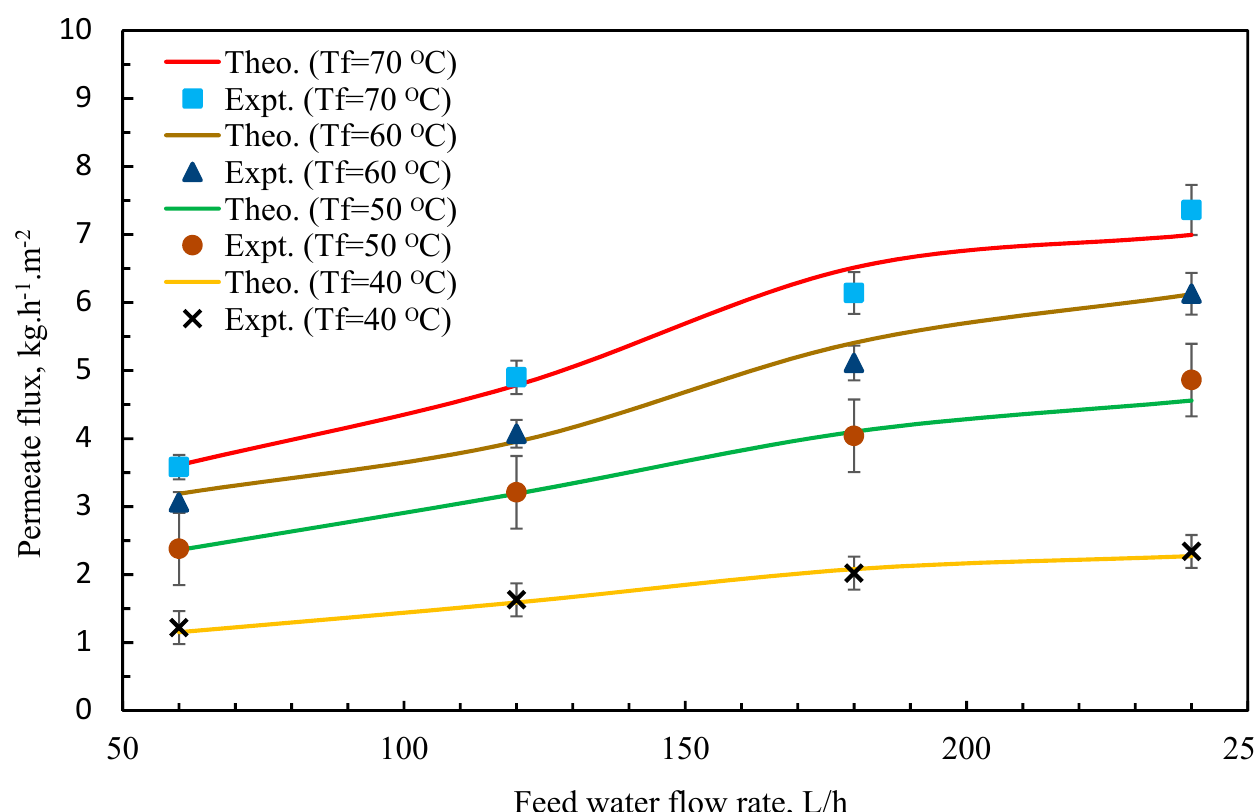
Figure 6. Comparison between theoretical and experimental flux at various feed water flow rate and temperature.